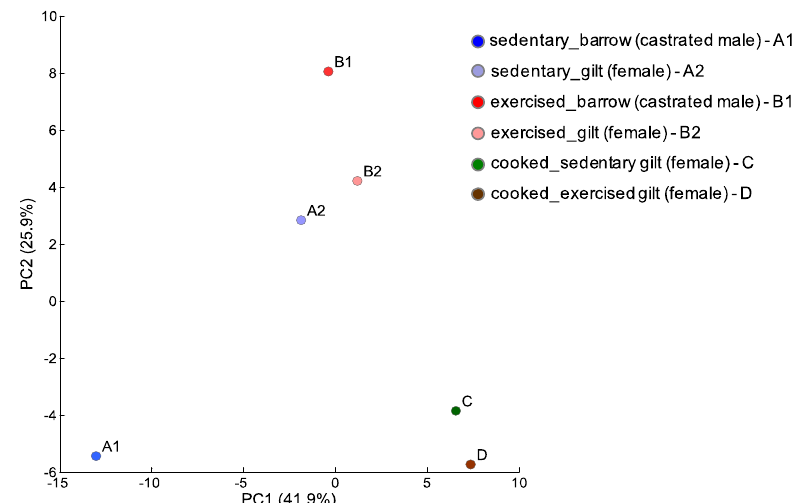
Figure2. Principalcomponentanalysis(PCA)oftheporcinelongissimusdorsi(LD)musclemetabolomic profiles of sedentary or exercising barrows and gilts. We also analyzed cooked gilt LD muscles.